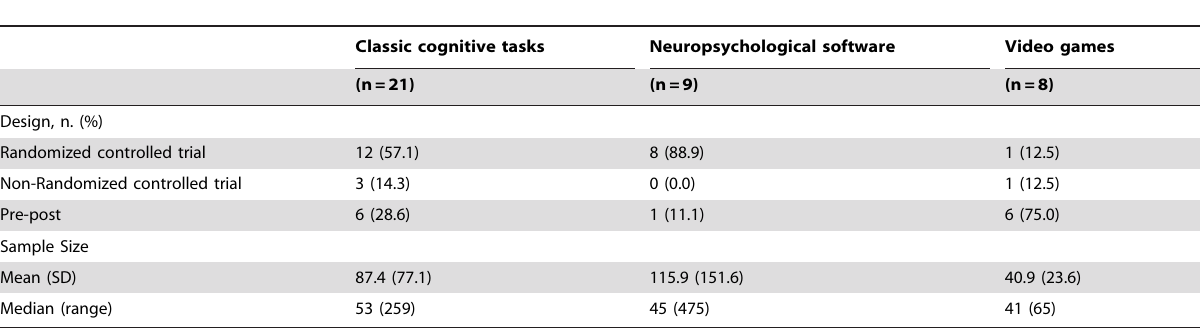
Table 4. Descriptive Statistics of Computerized Cognitive Training